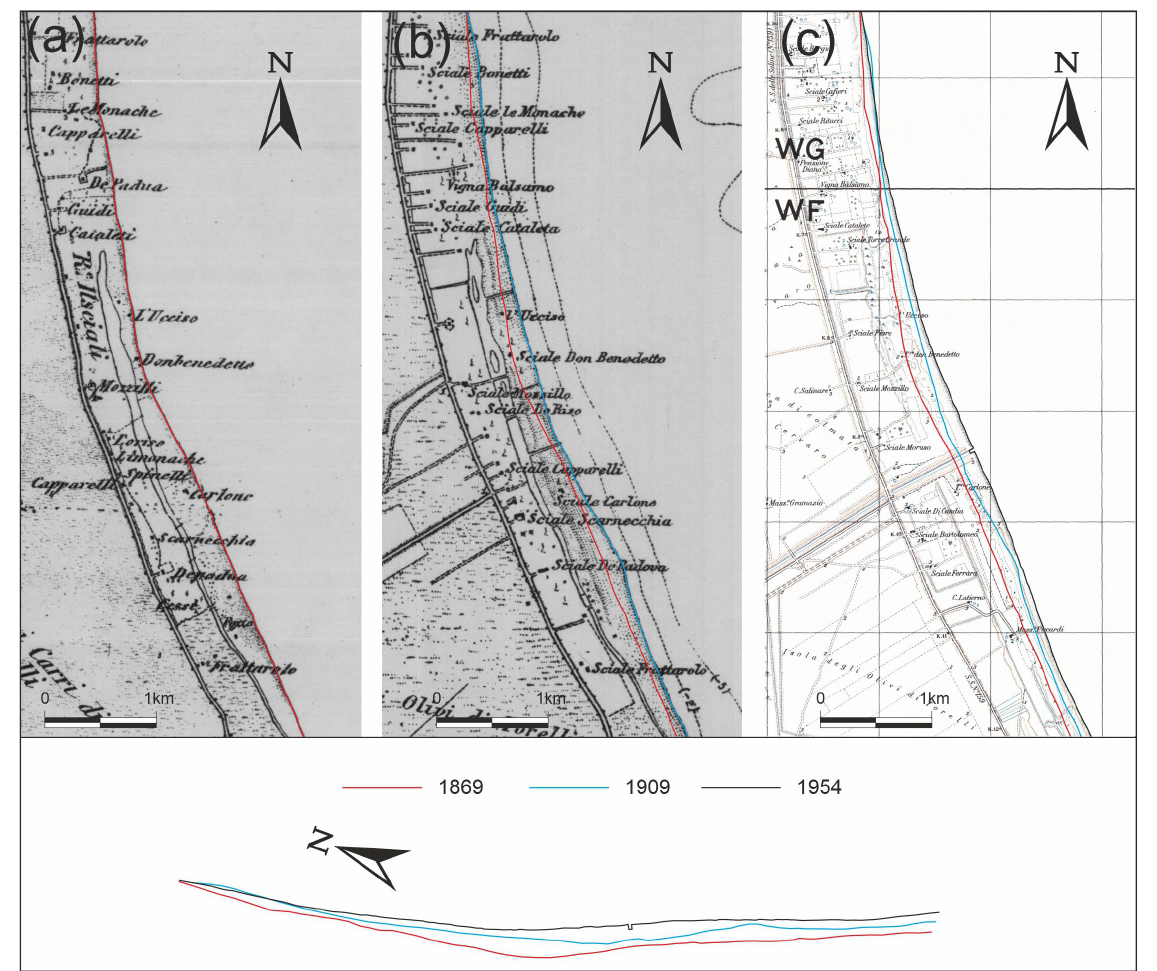
Figure 13. Shoreline displacement around the Cervaro stream mouth between 1869 and 1954, reconstructed based on topographic maps of ( a ) 1869, ( b ) 1909, and ( c ) 1954. Note that the Cervaro stream only flows to the sea in the 1954 topographic map, as previously it flowed more inland in the coastal marshes/polders around Salso lake. Maps from Istituto Geografico Militare (licence number 7156 of 15 March 2023; www.igmi.org (accessed on 5 February